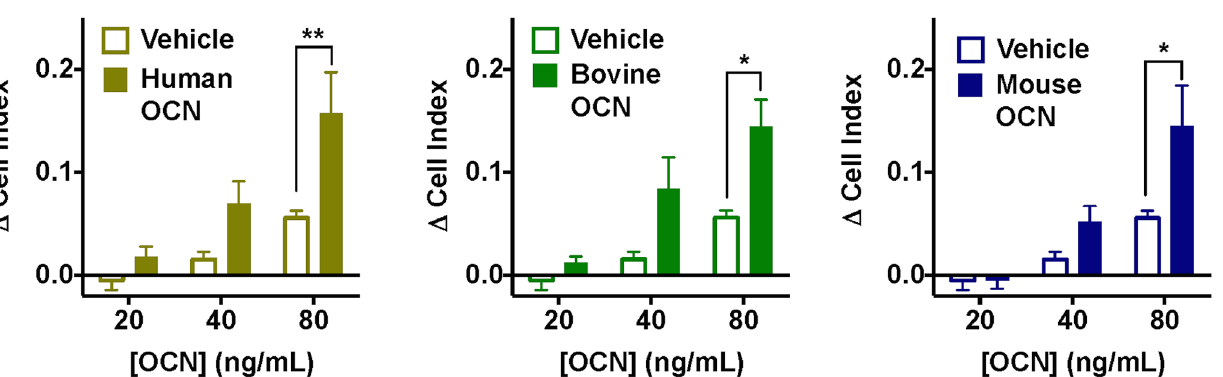
Fig 7. Measurement of cellular impedance in Gprc6a -negative rat INS-1(832) cells. Concentration-dependent increases in cell index (a measure of impedance) in INS-1(832) cells (that do not express Gprc6a ) with synthetic human, purified bovine and synthetic mouse OCN. Statistical analysis performed by two-way ANOVA ([OCN] and treatment); there was a significant effect of both [OCN] and treatment for all studies; * P < 0.05, ** P < 0.01 vs. Vehicle by Sidak ’ s multiple comparison test.